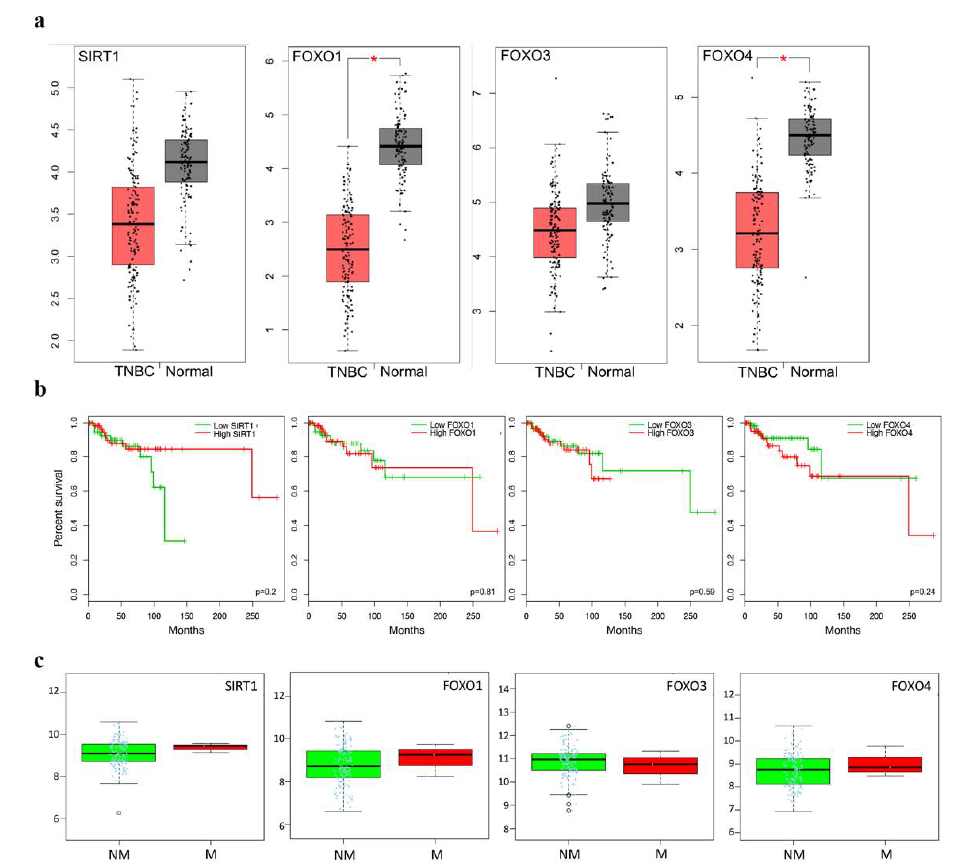
Figure 6. The mRNA expression of FoxO family members and SIRT1 in TNBC patients of TCGA. ( a ) mRNA expression of FoxO members and SIRT1 between TNBC and normal tissues in TCGA ( n : 135, n : 112, respectively). * shows p value < 0.05. ( b ) Overall survival of TNBC patients according to Kaplan–Meier analysis ( n = 134). ( c ) Comparisons of gene expression between tumor samples of TNBC patients in the metastasis stage (NM: non-metastasis, M: metastasis) ( n = 137).